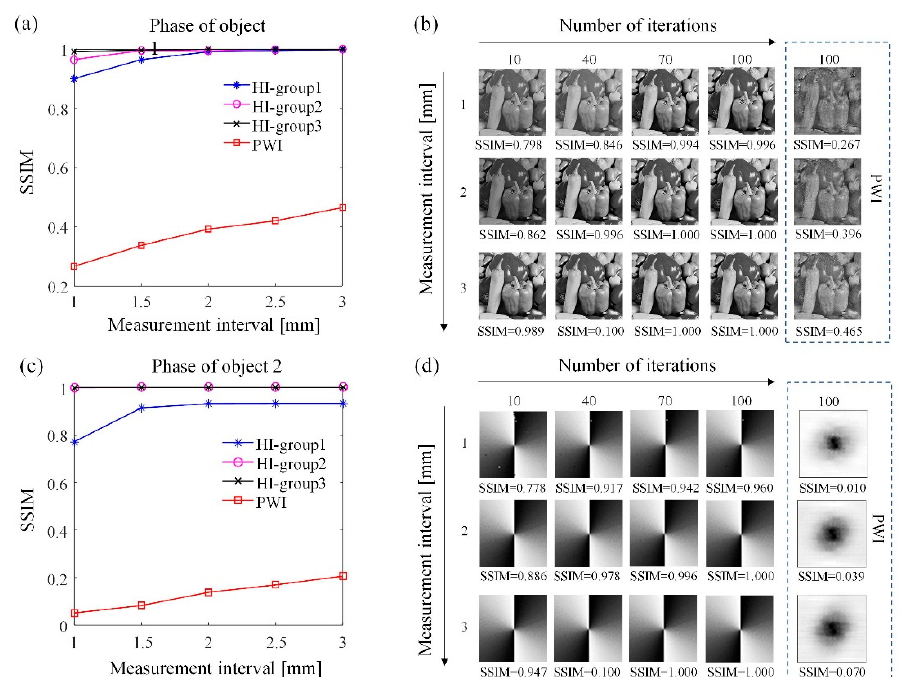
Figure 7. The reconstruction performance with different measurement interval. ( a , c ) are the con- vergence accuracy curves of phase of object 1 and phase of object 2 in terms of the sequential measurement distance for different types of illumination. ( b , d ) is the reconstruction images of the phase of object 1 and phase of object 2 with the increase of iteration times and measurement inter- val.